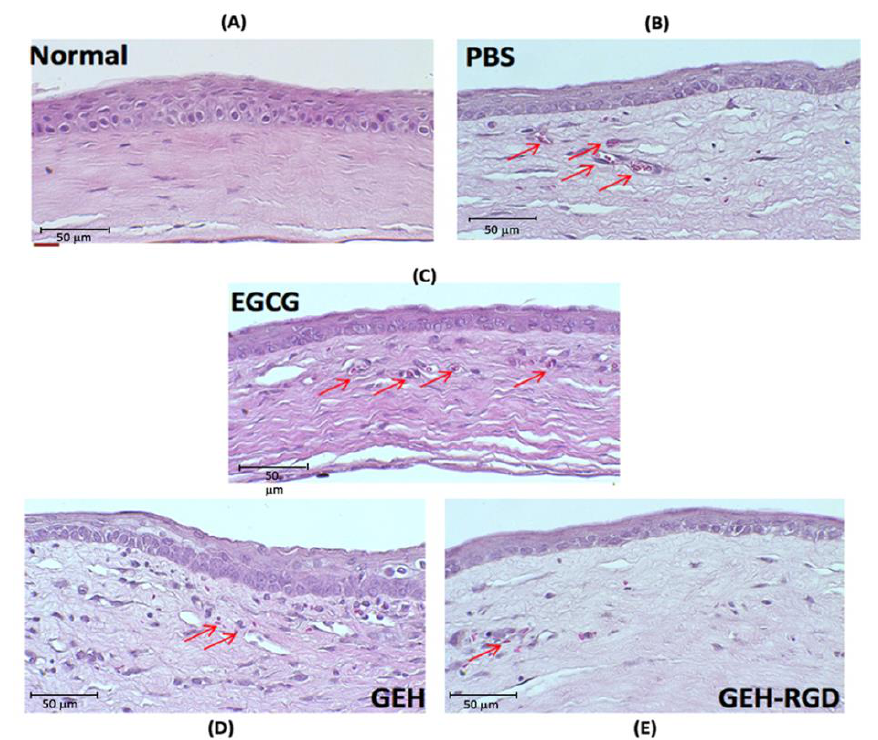
Figure 5. Histological assessment of corneal sections after treatment. Representative images of the central corneal section were depicted on day 7 following chemical cauterization. The development of fibrovascular proliferation was observed (red arrows). Groups: ( A ) normal, ( B ) PBS, ( C ) EGCG, ( D ) GEH, ( E ) GEH-RGD. Abbreviation: PBS: Phosphate buffer saline, EGCG: epigallocatechin-3 gallate, HA: hyaluronic acid, RGD: arginine-glycine-aspartic acid, GE: Gelatin/EGCG self-assembling nanoparticles (NPs), GEH: GE NPs with HA surface coating, GEH-RGD: GE NPs with HA-RGD surface decoration.